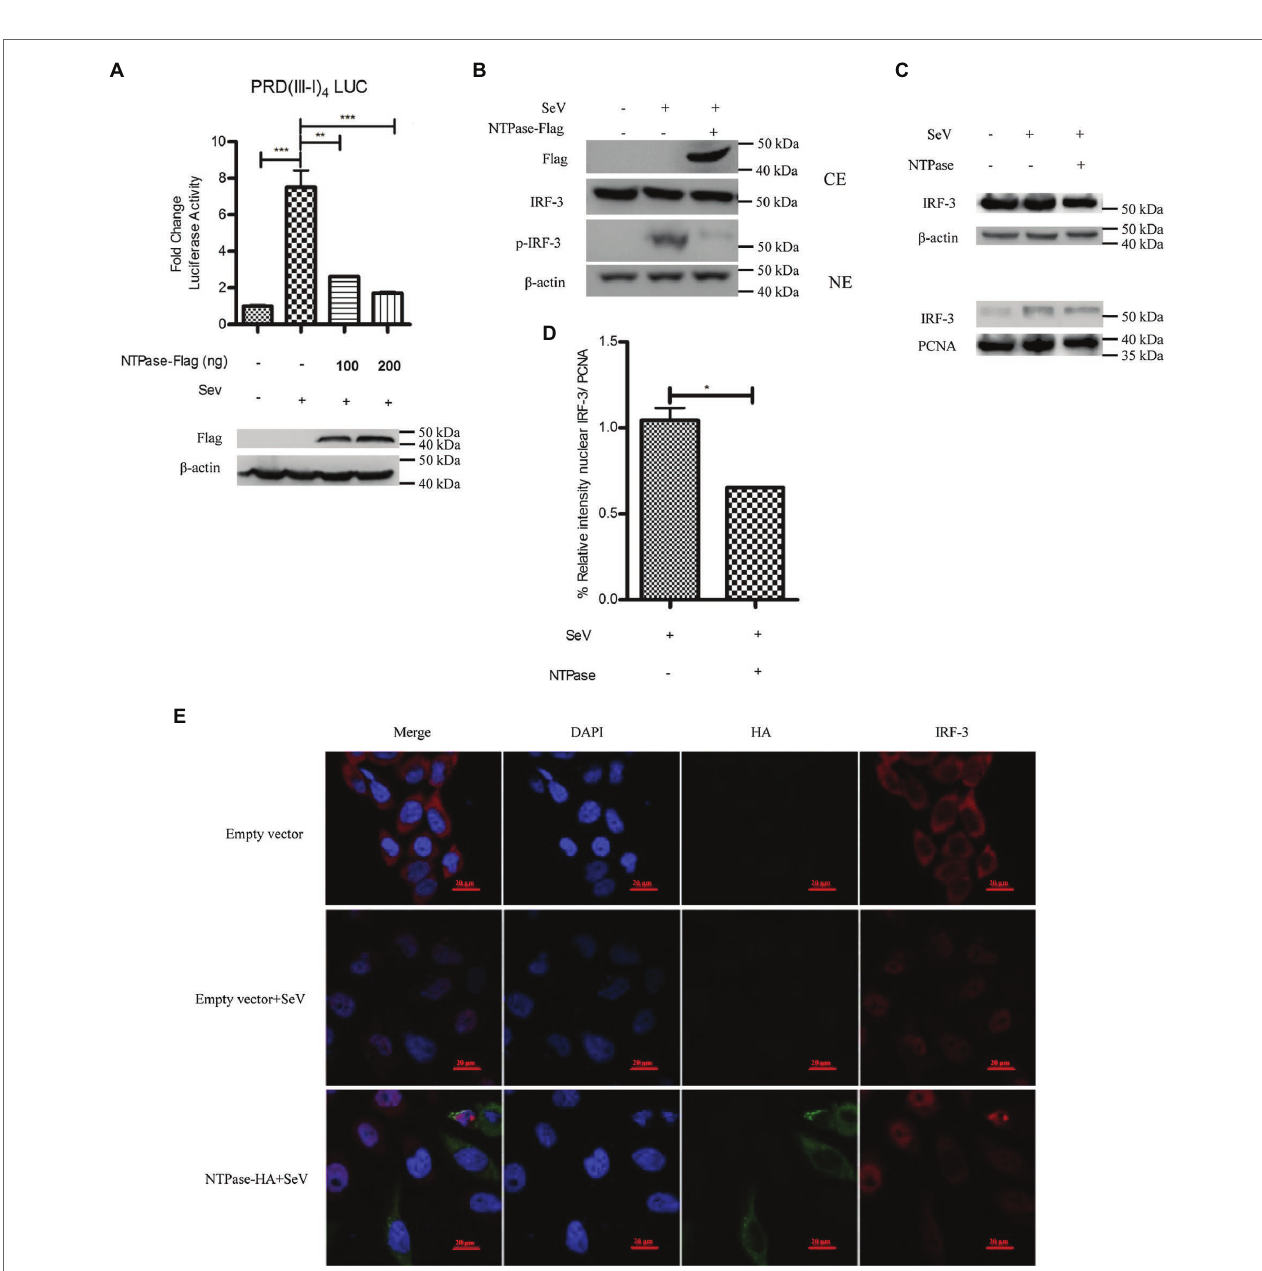
FIGURE 2 | transfected with various amounts of plasmid expressing NTPase or empty vector for 24 h followed by stimulation with or without SeV for 16 h. Total RNA was extracted from transfected cells to measure IFN- β mRNA by real-time PCR, while IFN- β released in supernatants was determined by ELISA. (D) HuNoV NTPase inhibits Poly(I:C)-induced activation of IFN- β promoter. HEK 293T cells in 48-well plates were cotransfected with various amounts of Flag-tagged NTPase expression plasmid or empty vector together with 100 ng p125-Luc and 20 ng phRL-TK. At 24 h posttransfection, cells were transfected with or without 0.5 μ g/ml Poly(I:C) for 16 h. Reporter activities were determined with DLR assay. (E) HuNoV NTPase inhibits the Poly(I:C)-induced production of IFN- β mRNA. HEK 293T cells in 6-well plates were transfected with various amounts of plasmid expressing NTPase or empty vector for 24 h followed by transfection with or without 0.5 μ g/ml Poly(I:C) for 16 h. Total RNA was extracted from transfected cells to measure IFN- β mRNA by real-time PCR. The expression of HuNoV NTPase protein was detected using an anti-Flag Ab or anti-HA Ab, with β -actin being used as a loading control. One representative experiment out of three is shown for WB. For graphs, data shown are mean ± SD of three independent experiments, with each condition performed in triplicate. *** p < 0.001; ** p < 0.01; * p < 0.05; and ns, not significant.